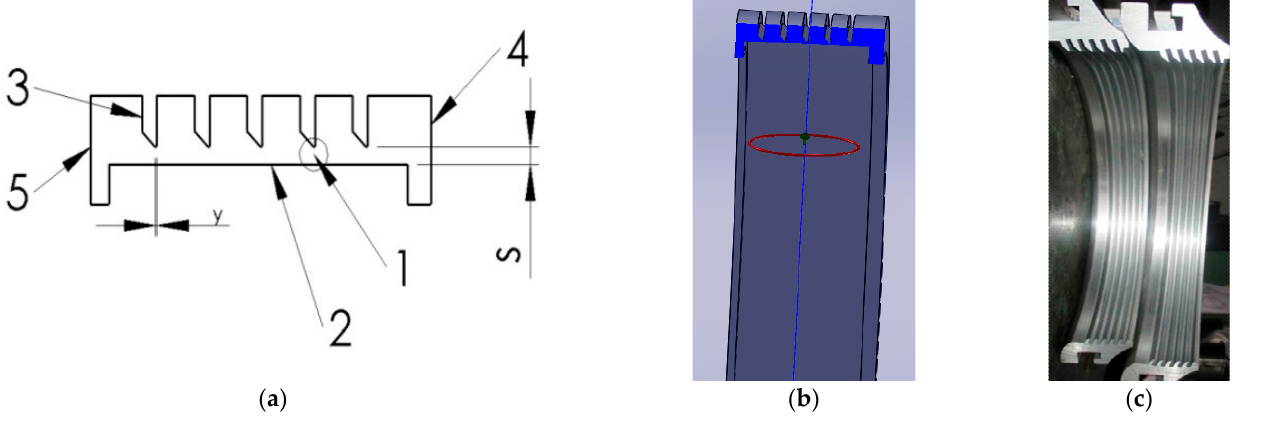
Figure 1. Labyrinth seal: ( a ) sketch of the flow path of the labyrinth seal, 1—slot (radial clearance s ), 2—shaft, 3—sealing comb, 4—input section, 5—output section, y —sharp edge ( y = 0.15 mm); ( b ) 3D model of the flow part of the labyrinth seal; ( c ) detachable labyrinth seal.